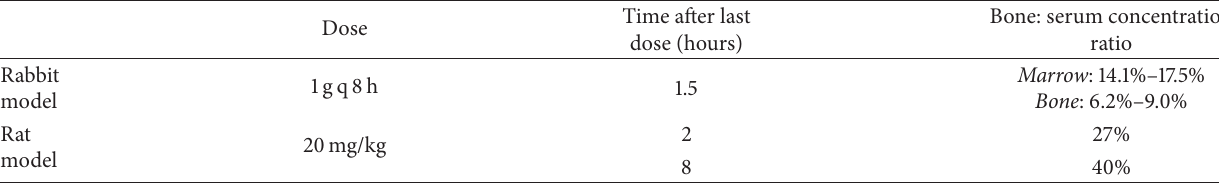
Table 1: Ratio of ceftolozane concentrations between bone tissue and plasma.